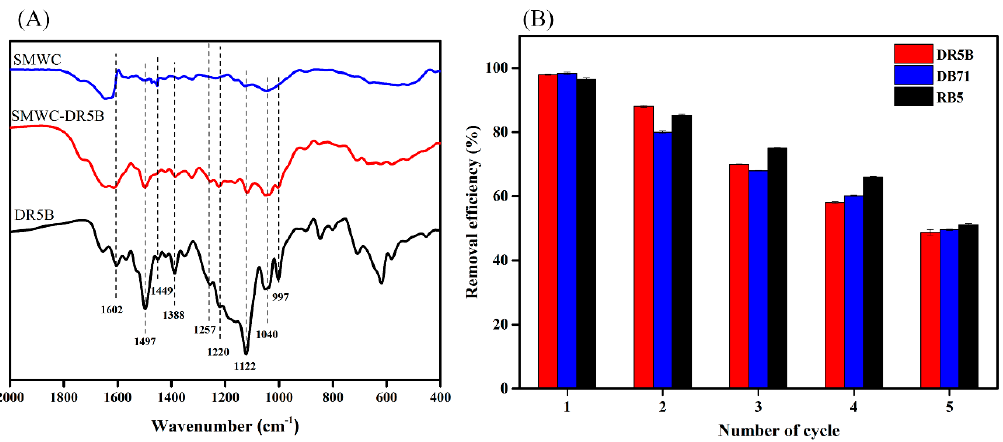
Figure 8. FTIR spectra of SMWC, SMWC-DR5B, and DR5B alone ( A ); Dye adsorption of SMWC at five regeneration cycles ( B ).